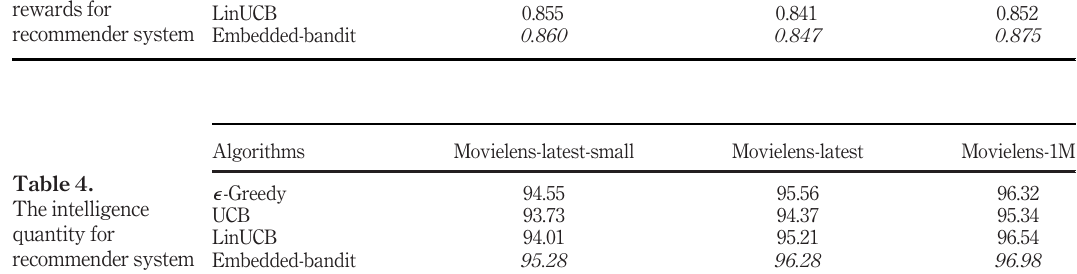
quantity for recommender system